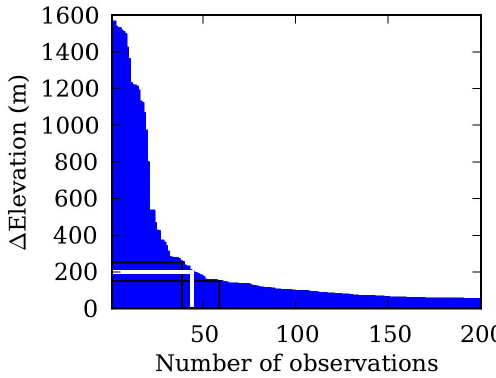
Fig. 5. Distribution of the difference in elevation between ob- served data and data from the digital elevation model of Bamber et al. (2009). The white lines represent the 200m threshold which led to the rejection of 44